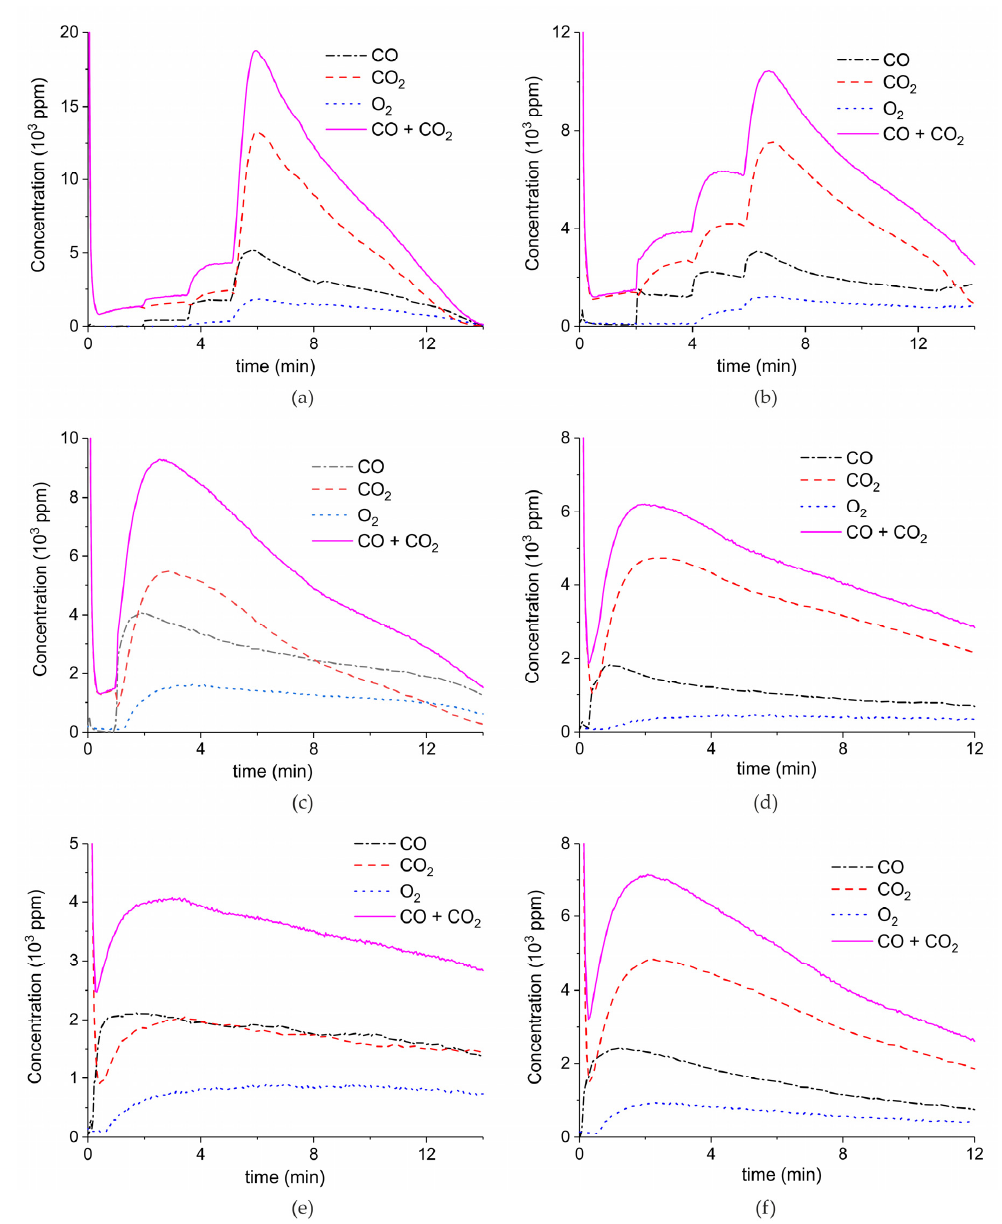
Figure A1. Concentration of the products of CaCO 3 decomposition (sample A) as function of time at 630 °C in pure argon and flow rate of 30 mL/min. Plasma power is 0.3, 1.4, and 8.4 W ( a ); 1.4, 3.5, and 6.4 W ( b ); 5.1 W ( c ); 3.9 W ( d ); 2.2 W ( e ); and 3.7 W ( f ). Plasma is turned on after 2 min and changed every 2 min (a,b), after 1.5 min (c), or at the beginning of the decomposition (d–f).